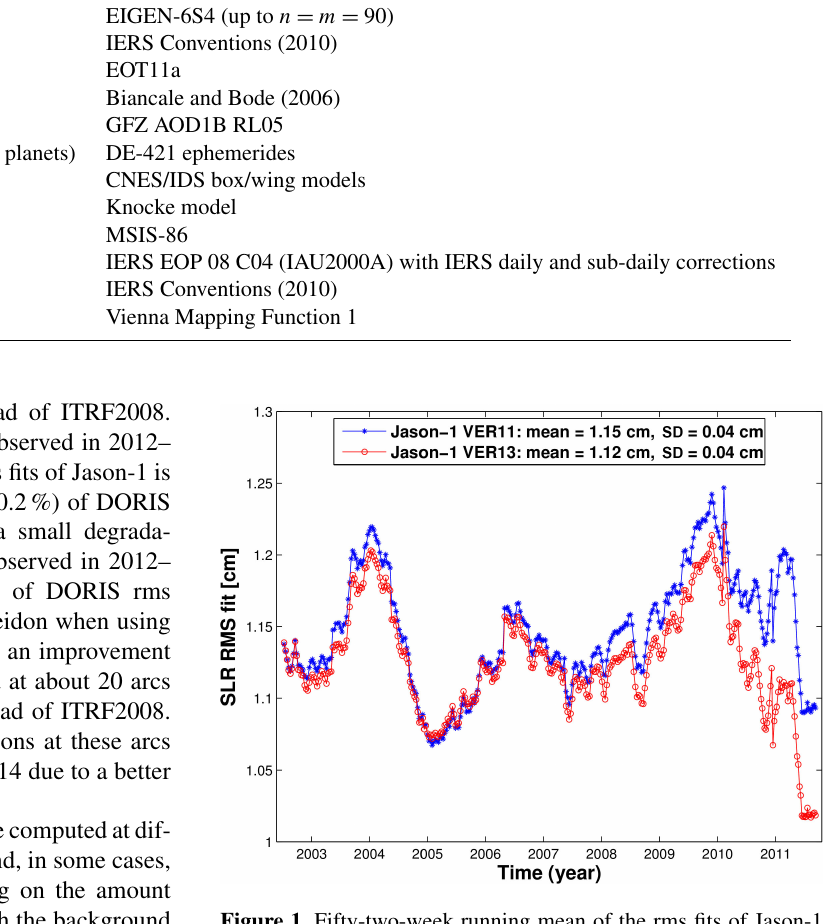
Figure 1. Fifty-two-week running mean of the rms fits of Jason-1 SLR observations obtained using ITRF2014 (VER13 orbit) and ITRF2008 (VER11 orbit) from 13 January 2002 to 16 Febru- ary 2012. SD denotes standard